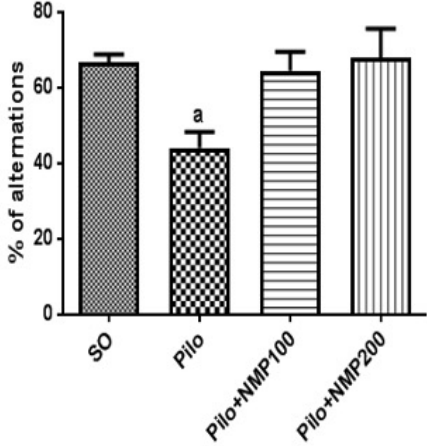
Figure2. The N -methyl-(2S,4R)-trans-4-hydroxy- l -proline-richfraction(NMP)preventedthebehavioral changes in the operational memory, induced by the intracerebroventricular (icv) injection of pilocarpine (Pilo), evaluated by the Y-maze test in mice. The animals received Pilo (300 µ g / 1 µ L, icv) and, 24 h after, were treated for 15 days with NMP (100 or 200 mg / kg, per os , po ; Pilo + NMP groups) or with distilled water (vehicle po ; sham-operated, SO). Groups were composed of eight animals / group on average. The behavioral tests were performed 1 h after the last drug administration. a. vs. SO, p = 0.0063 (one-way analysis of variance followed by Dunnett’s multiple comparisons